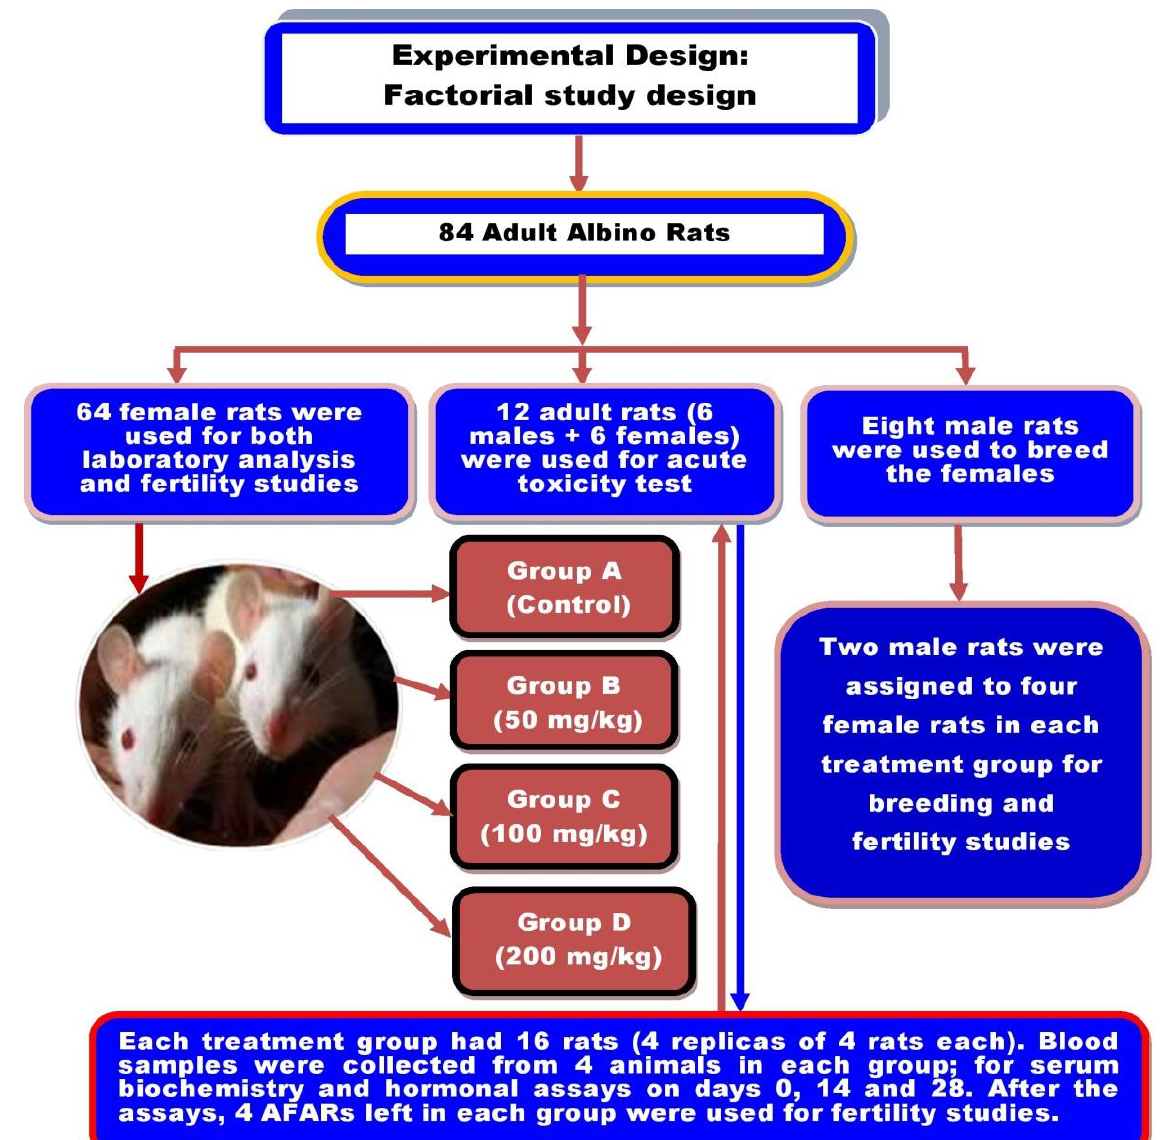
Figure 2. A Schematic representation of the groupings of experimental animals.